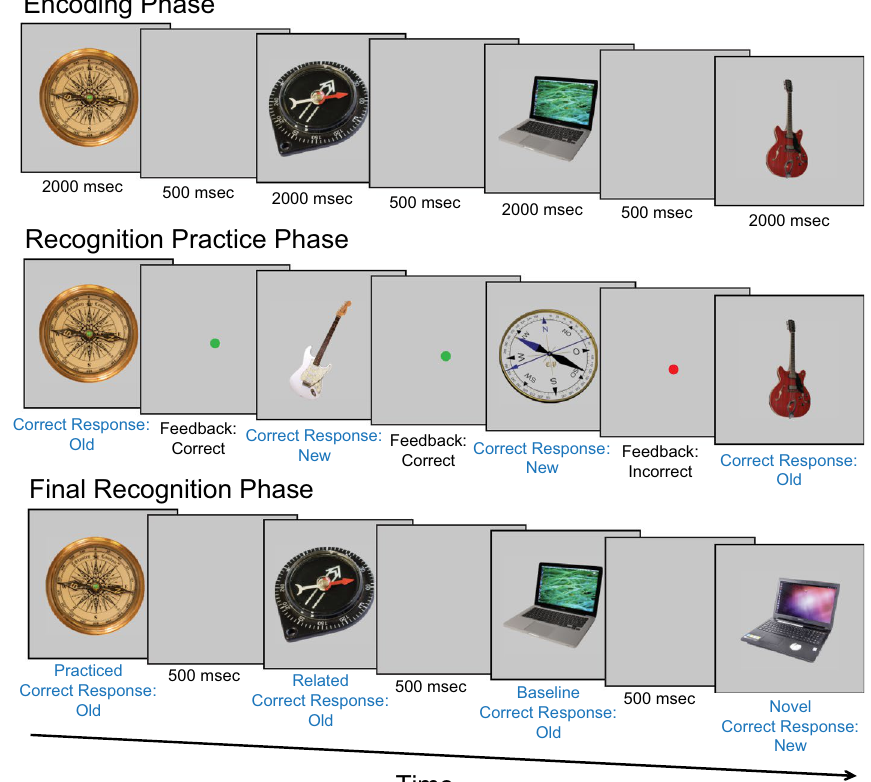
Figure 1. Brief overview of Fukuda, Pall 8 methods. Objects were sequentially presented for 2 s each during the encoding phase. Then memory for half of the objects from half of the categories was tested in the recognition practice phase. Memory for all objects was then tested in the final recognition